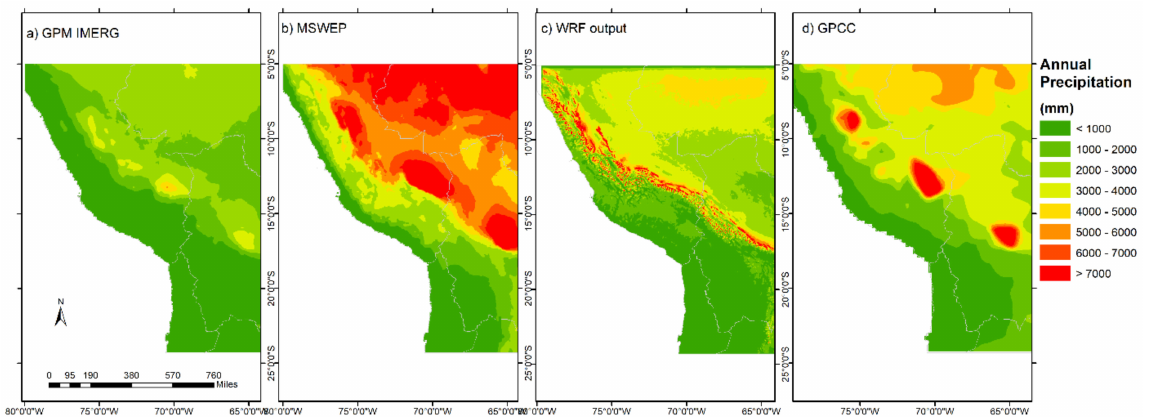
Figure 3. The 10-year average annual precipitation from 2010 to 2019 of ( a ) GPM IMERG, ( b ) MSWEP, ( c ) WRF simulation, and ( d ) GPCC.